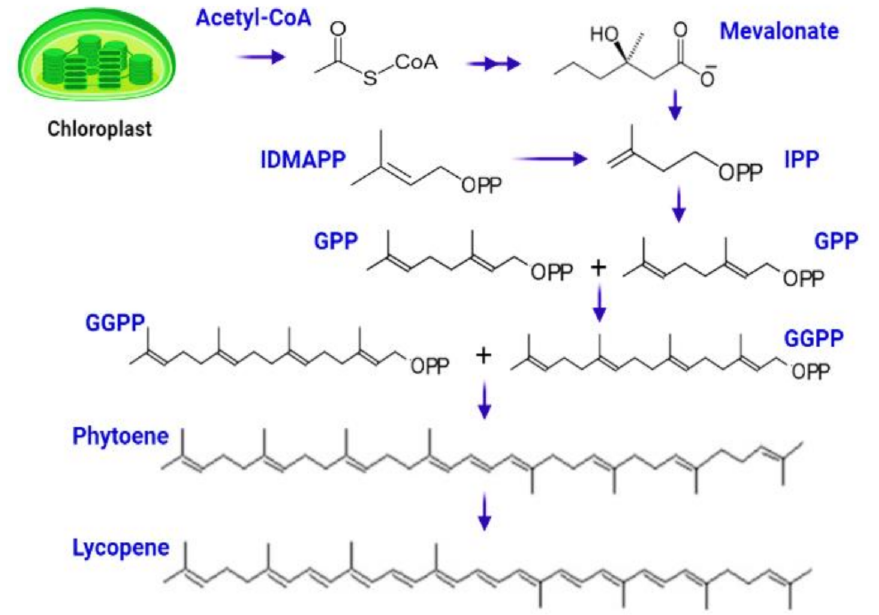
Figure 3. Biosynthesis of lycopene starts from central metabolite Acetyle-co-A, which is subsequently converted to IPP, GPP, GGPP, phytoene, and